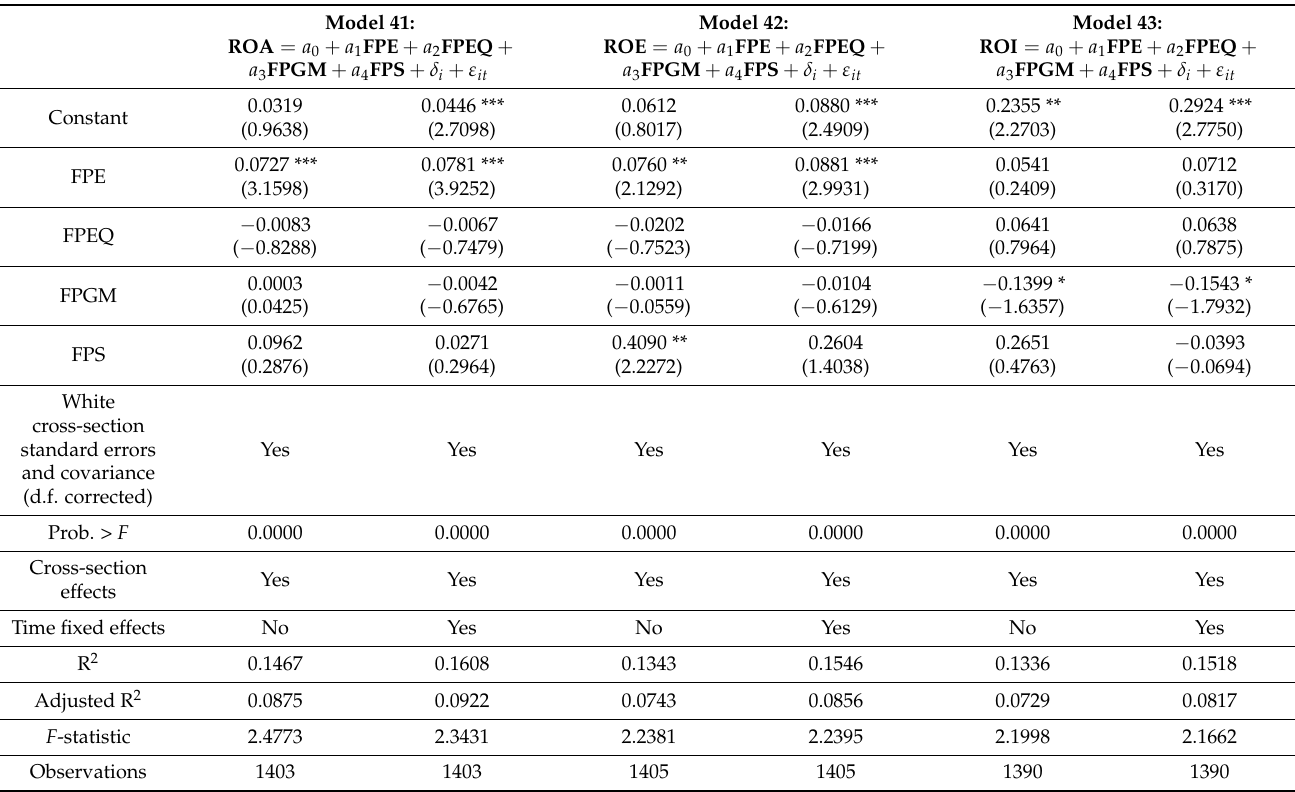
Table 14. Econometric models for the overall